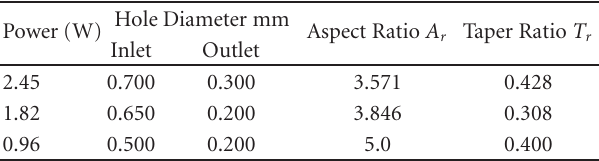
Figure 5: Di ff erent holes drilled by P = 2 . 45W, focal position at the surface, and with 20mmHg of assist gas.